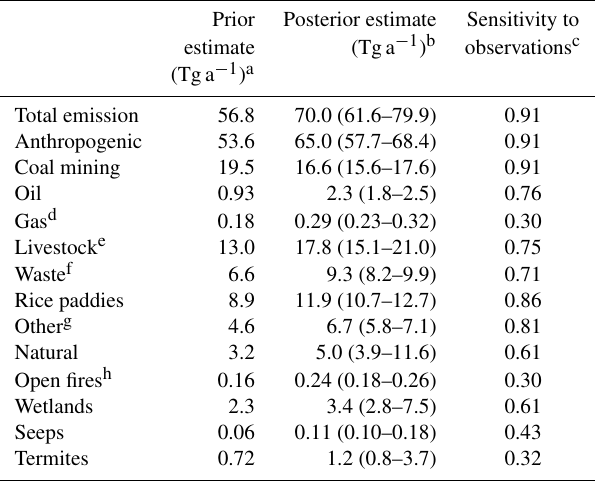
Table 1. Methane emissions in China in